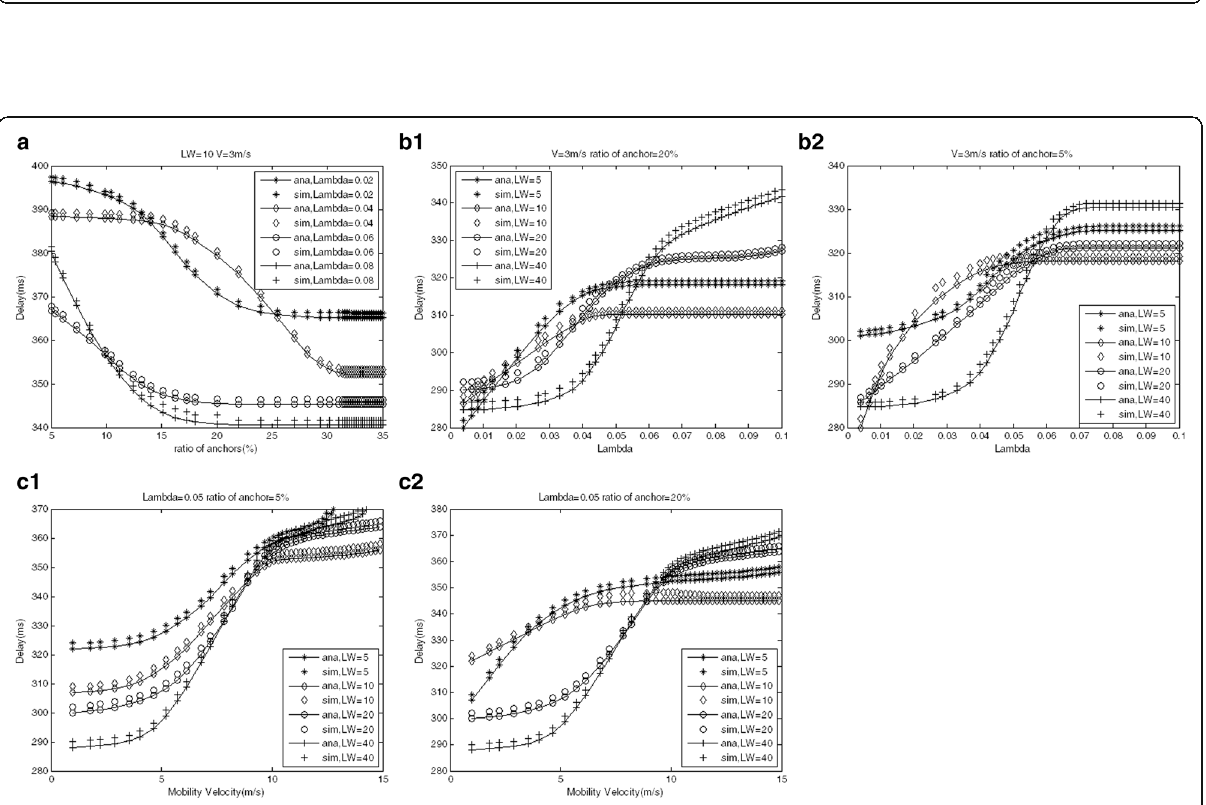
Fig. 7 a Localization error as a function of anchor ratio. b Localization error for localization window as a function of node density (concluding unknown nodes and anchors). c Localization error for localization window as a function of mobility velocity